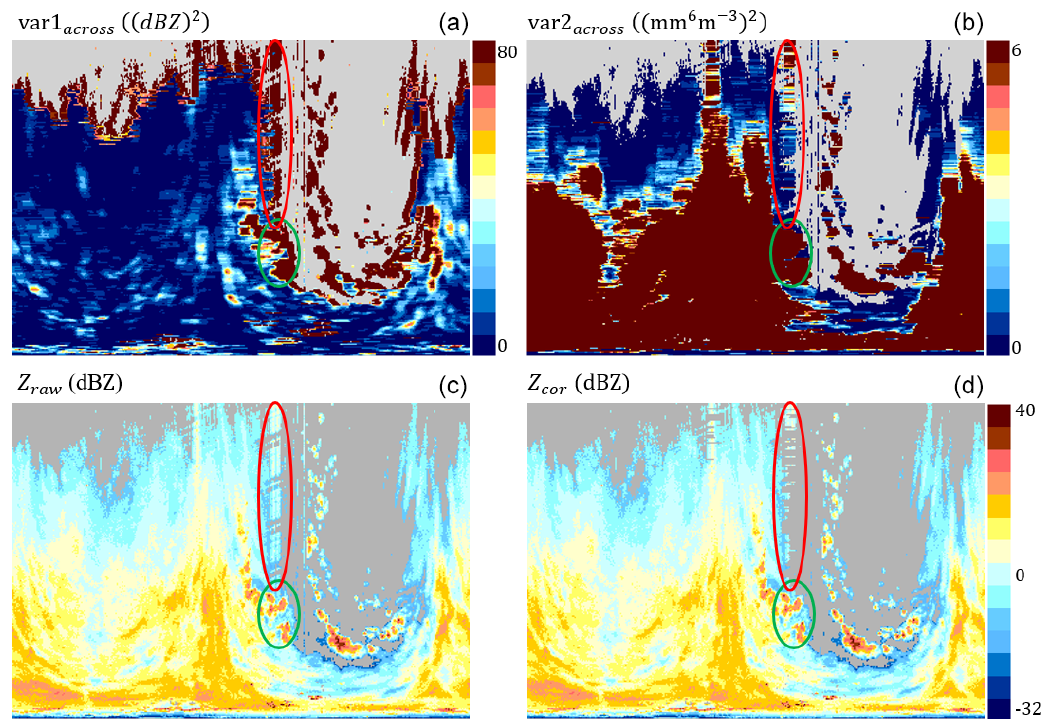
Figure 10. Example of the performance of the SPIKE and INTERP algorithms. (a, b) Variances of radar reflectivity across the radar beam calculated (a) in dBZ and (b) mm 6 m − 3 . (c, d) Radar reflectivity in dBZ: (c) raw ( Z raw ) and (d) corrected (interpolated) ( Z cor ). In the red ellipse: “discontinuous” spike echoes; in the green ellipse: meteorological echoes correctly not qualified as spikes. ´Swidwin radar, the lowest elevation, 9 May 2019,